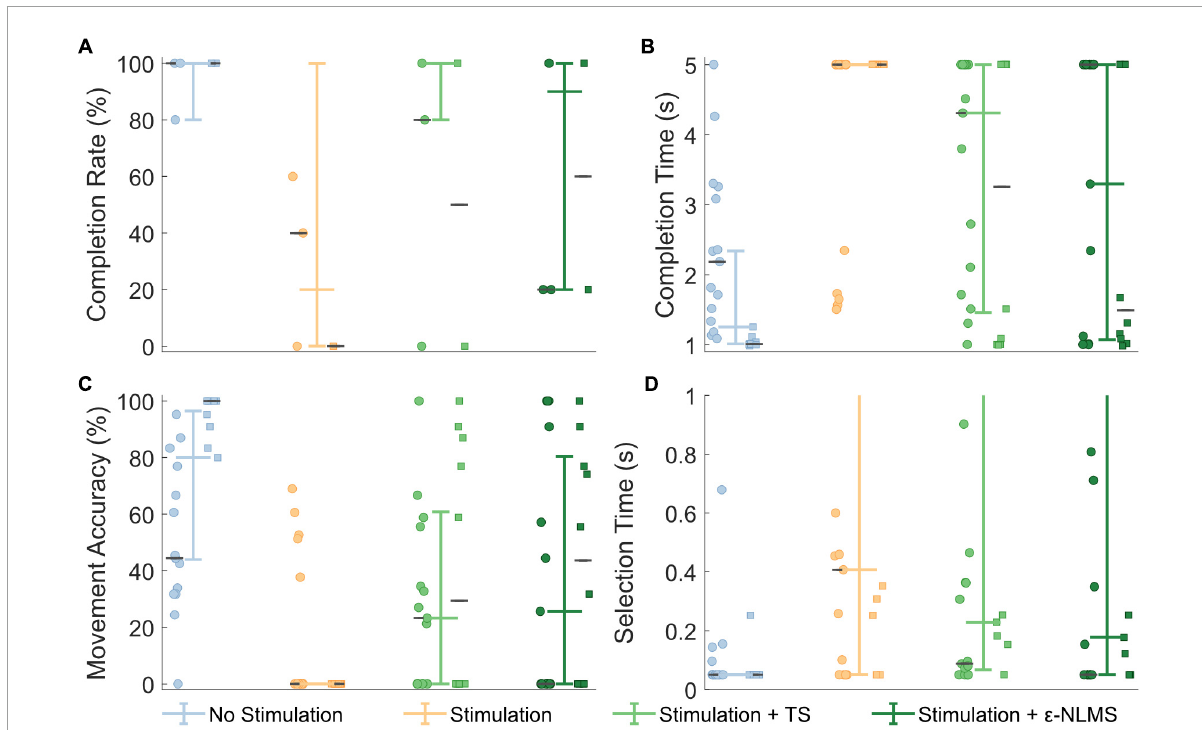
FIGURE7 Real-time Motion Test outcomes were deteriorated by neurostimulation, but performance was recovered when using artifact removal algorithms. Template Subtraction (TS) resulted in a significantly improved completion rate (A) , and ε -Normalized Least Mean Squares ( ε -NLMS) significantly reduced the movement completion time (B) and increased the movement accuracy (C) . Neither algorithm had a significant effect on selection time (D) . Colored whisker plots represent pooled median and interquartile range. Circle and square points represent data from the two participants, and the gray horizontal lines represent their individual